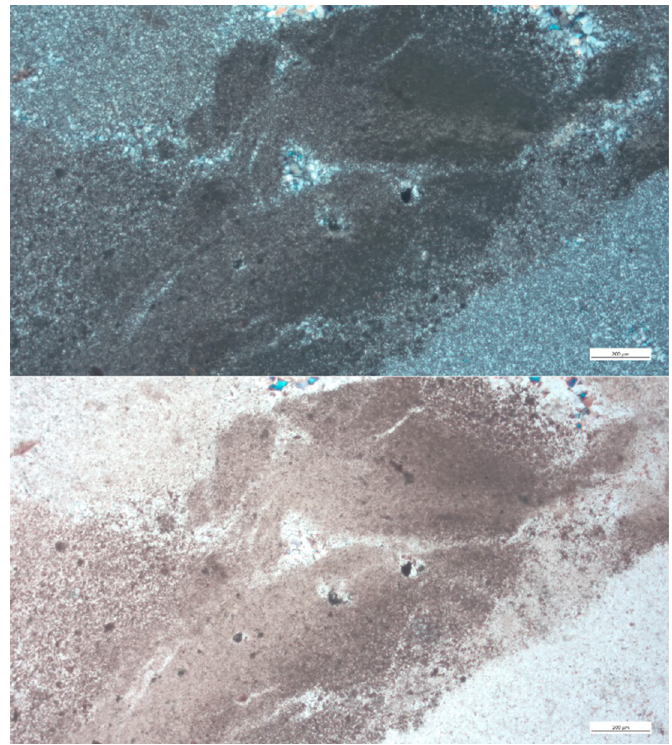
Fig 18. The brecciated texture of the Mishash flint, in cross polars (above) and in plain polars (below).